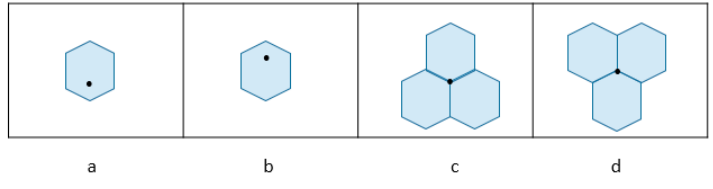
Figure 2. Location table T.